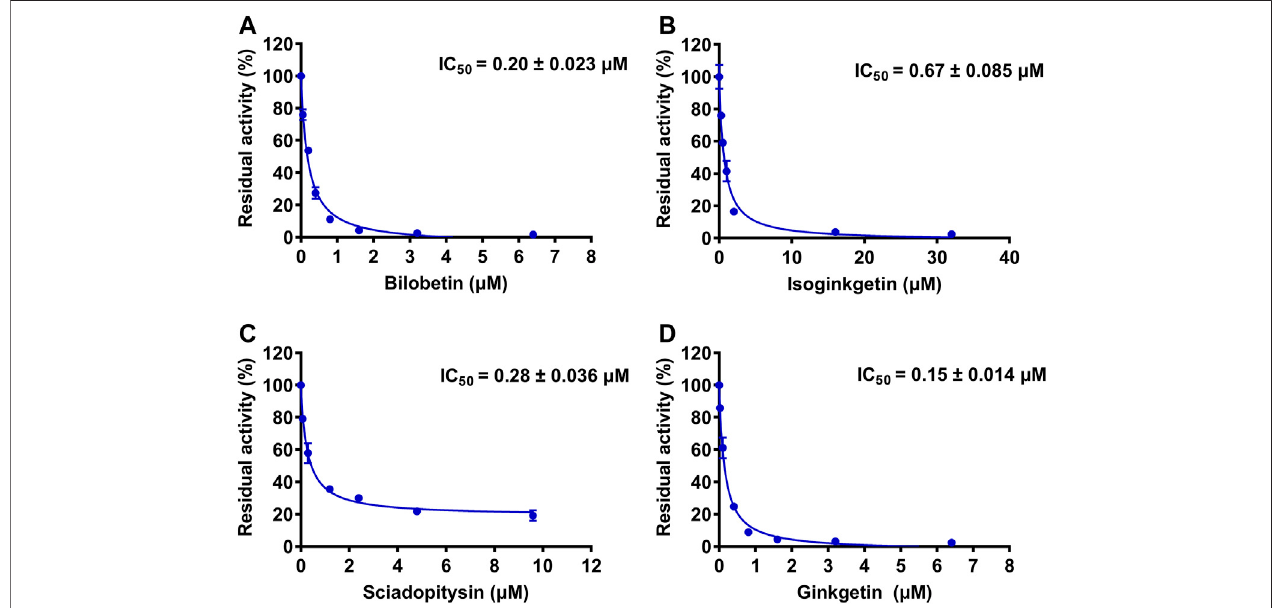
FIGURE 4 | The dose-dependent inhibition curves of isoginkgetin (A) , sciadopitysin (B) , bilobetin (C) and ginkfetin (D) on NHPN-O-glucuronidation in HLM. The data were expressed as the means of triplicate determinations.